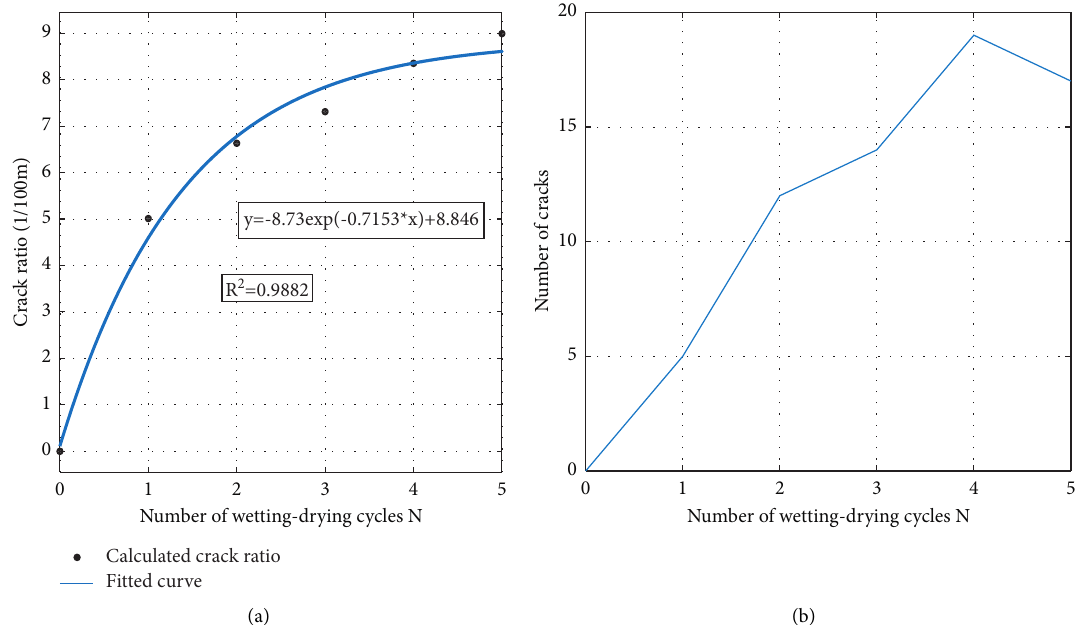
Figure 7: Relationship between crack ratio, number of cracks, and the number of wetting-drying cycles. (a) Crack ratio. (b) Crack